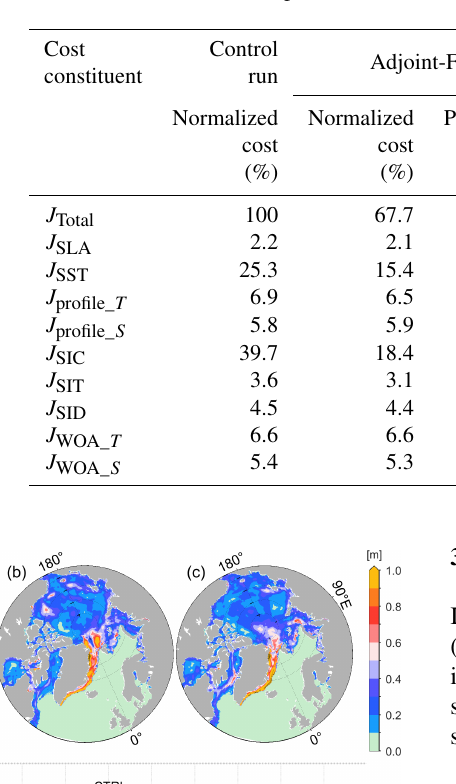
Table 2. Normalized costs and reductions in the two optimization runs.